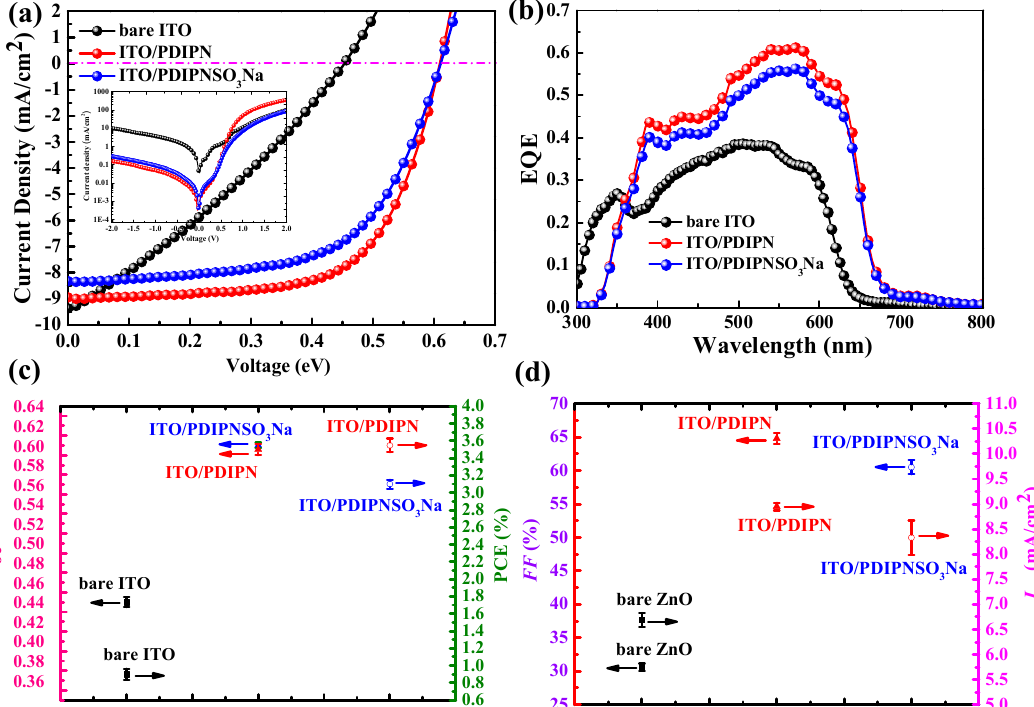
Figure 8. ( a ) J − V curves of devices based on P3HT:PC 61 BM with various ETLs under the illumination of AM1.5G, 100 mW cm − 2 (inset: under dark conditions), ( b ) EQE characteristics, ( c ) The standard deviations error bars of V oc and PCE and ( d ) the standard deviations error bars of and FF and J sc .